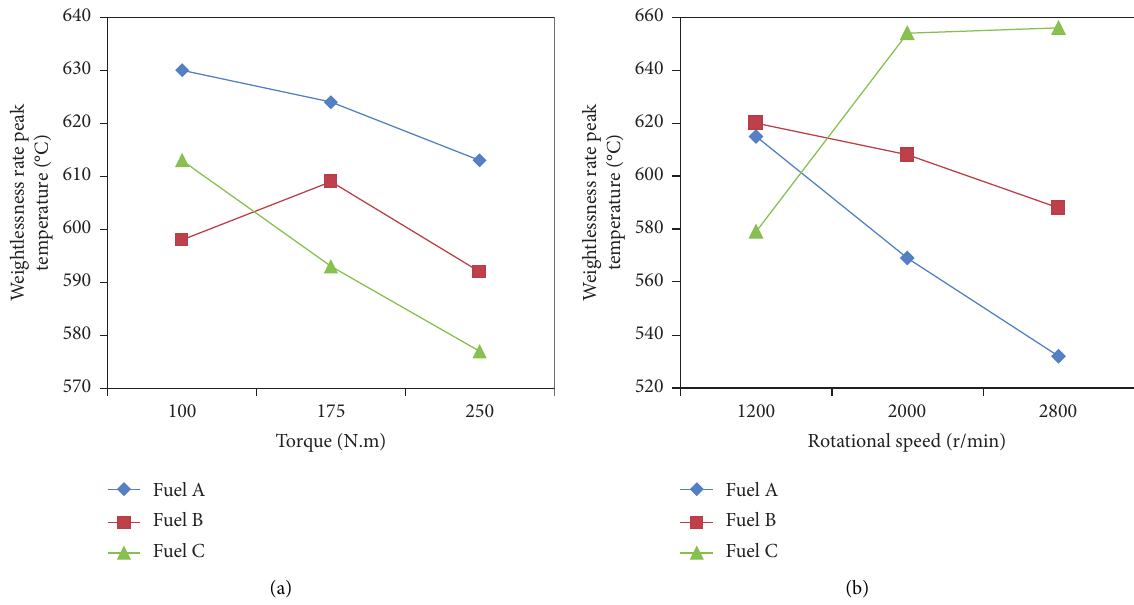
Figure 6: The weightlessness rate peak temperatures of PM under various operating conditions. (a) Different torque. (b) Different rotational speed.